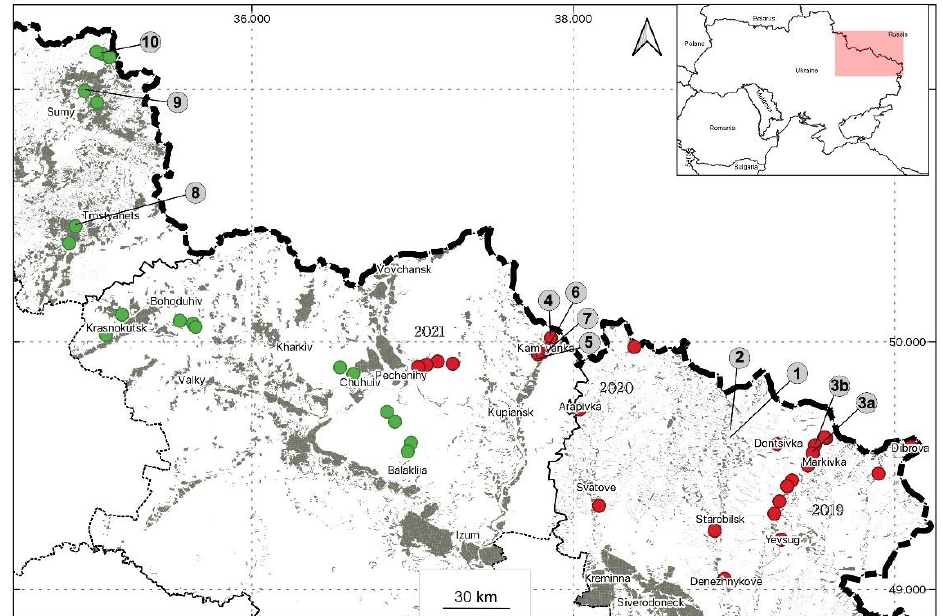
Figure 1. Map of eastern Ukraine showing locations of survey sites and monitoring plots of the present study. Red circles indicate survey sites where the emerald ash borer has been detected, and green indicates where the beetle has not been detected. Numbers of the monitoring plots correspond to those in the Tables 1 and 2. Table 1. Infestations of the ash dieback disease fungus Hymenoscyphus fraxineus (ADB) and emerald ash borer Agrilus planipennis (EAB) on Fraxinus pennsylvanica and F. excelsior trees in eastern Ukraine. The plots are as shown in Figure 1.